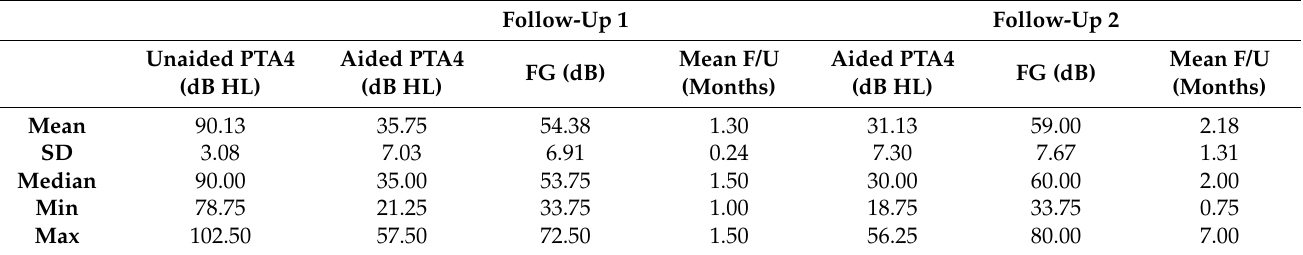
Table 1. Soundfield audiometry (PTA 4).